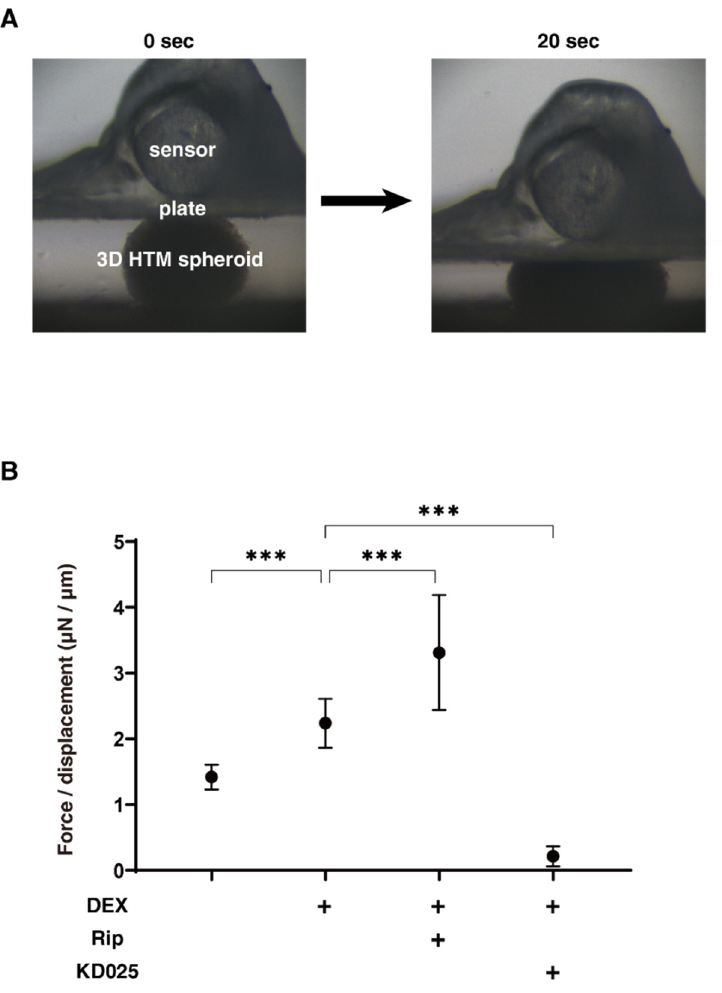
Figure 3. Physical solidity of 3D HTM spheroids. ( A ) Representative photos demonstrating the micro-squeezer analysis measured over a period of 20 s. On Day 6, the force (µN) required to induce a 50% deformity of every 1 out of 15–20 freshly prepared 3D HTM spheroids (non-treated control) and those treated with 250 nM DEX in the absence or presence of 10 µM ROCK-i, ripasudil (Rip) or KD025 were measured, and force/displacement (µN/µm) values were plotted in ( B ). These experiments were performed in triplicate using fresh preparations ( n = 10). *** p < 0.005 (ANOVA followed by a Tukey’s multiple comparison test).